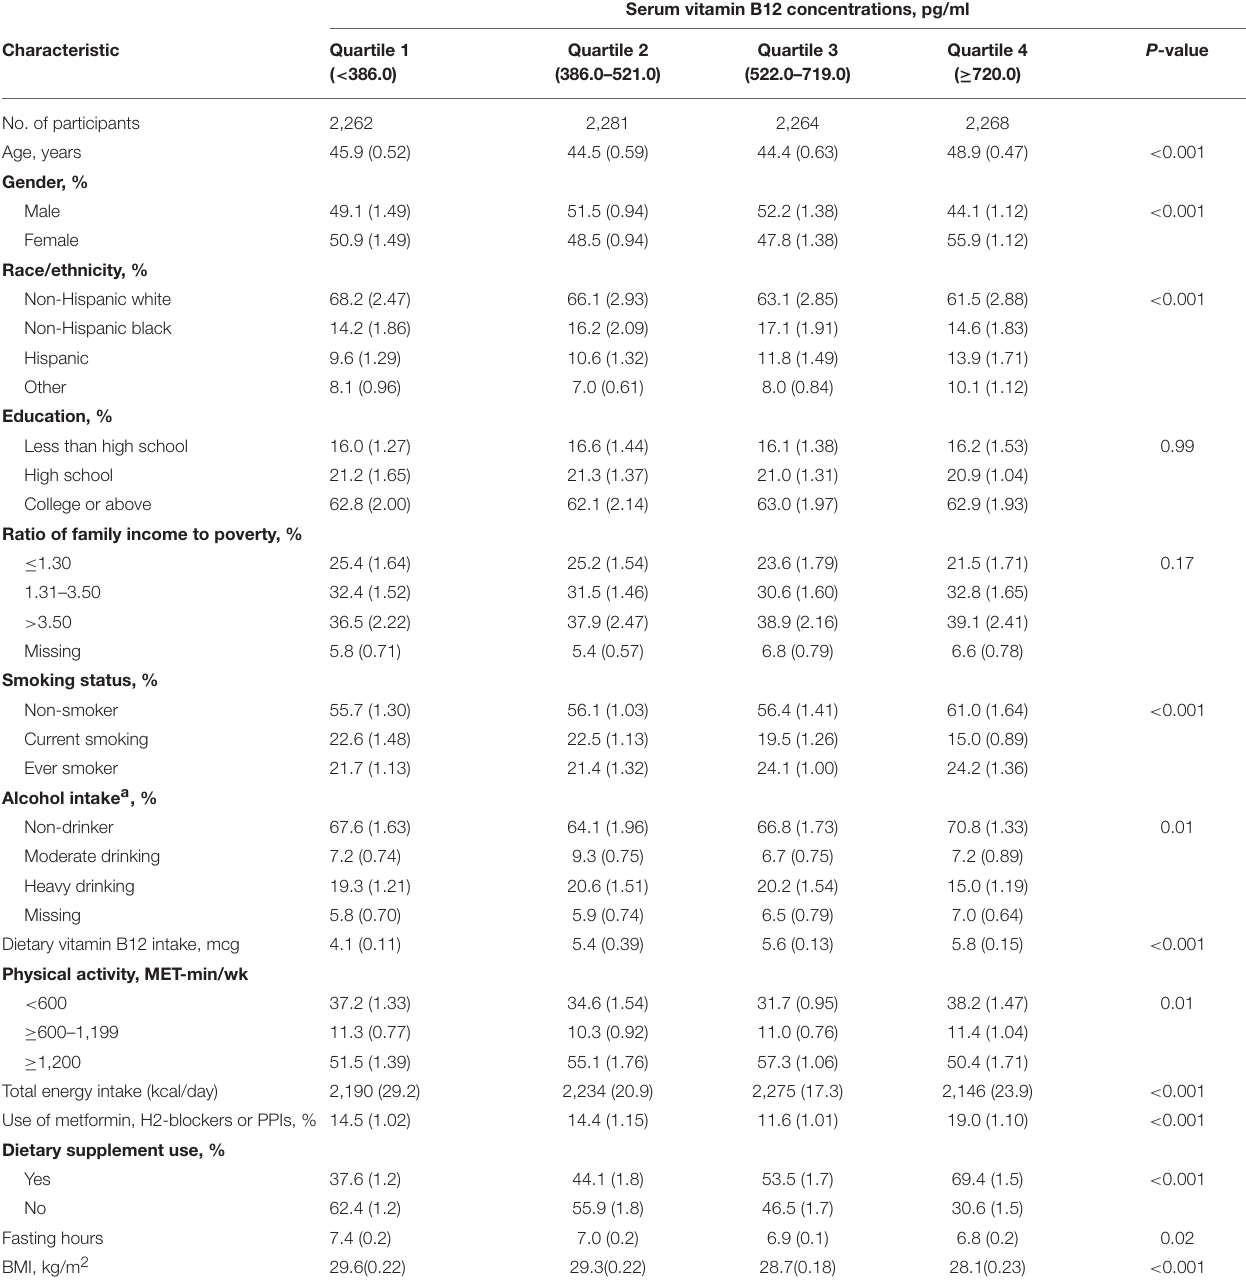
TABLE 1 | Characteristics of the study population ( n = 9,075), according to quartiles of serum vitamin B12 concentrations. Serum vitamin B12 concentrations, pg/ml